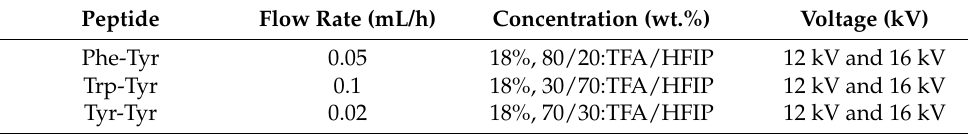
Table 1. Optimal conditions for electrospinning of peptides (TFA: trifluoroacetic acid) [25].